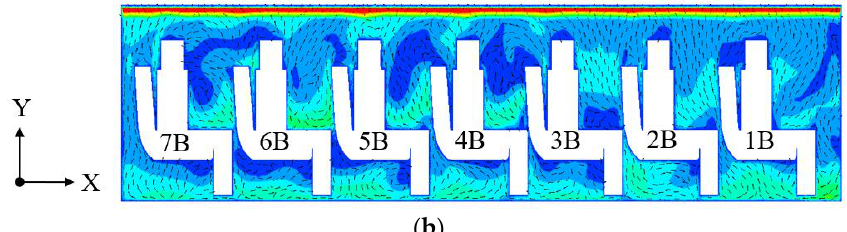
Figure 6. The modeled airflow distributions in Case 1: ( a ) airflow field in the cross-section across the fourth row, ( b ) airflow field in the longitudinal section across the B th column.